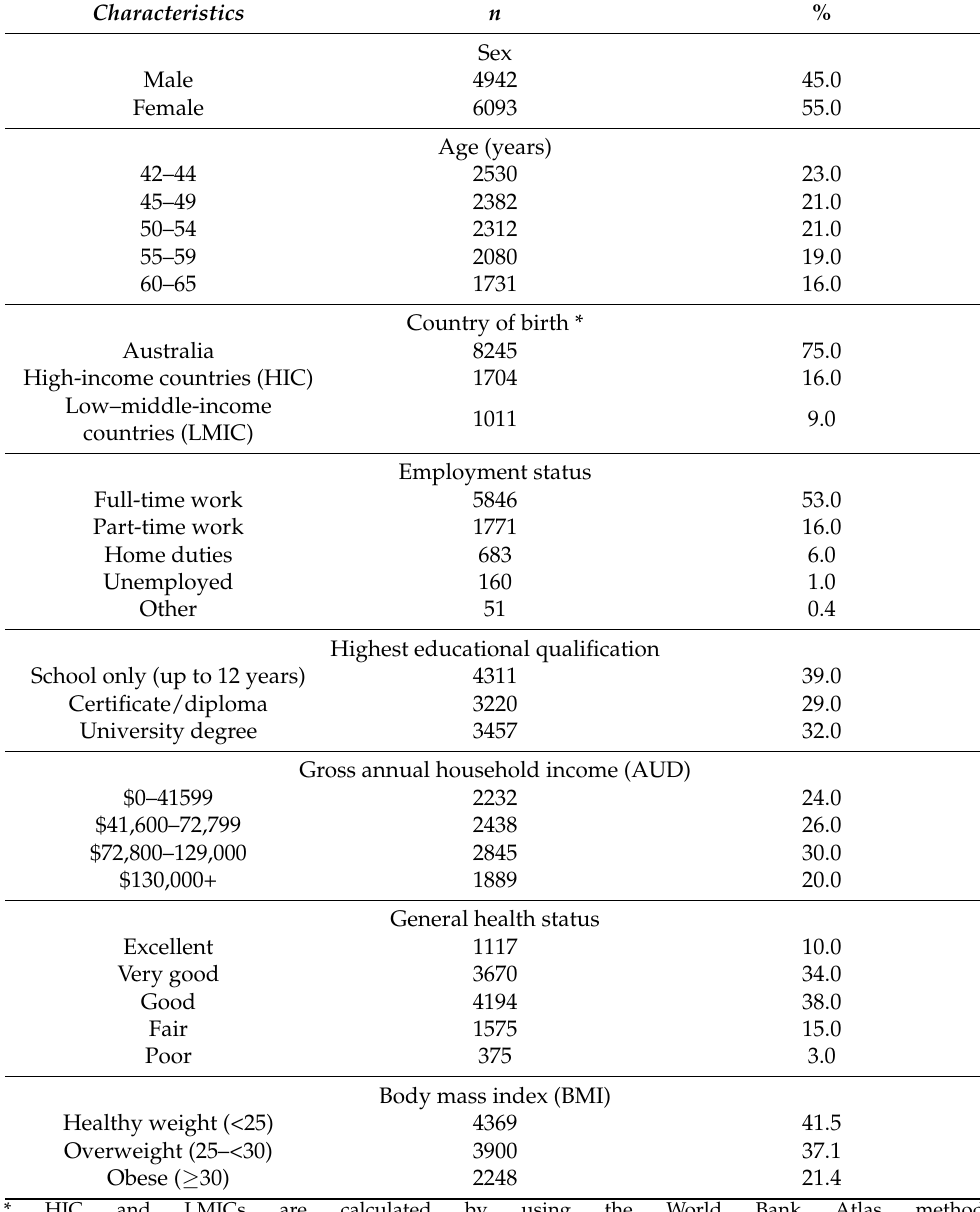
Table 1. Sociodemographic and health characteristics of the analytical sample at baseline ( n = 11,035), 2007.